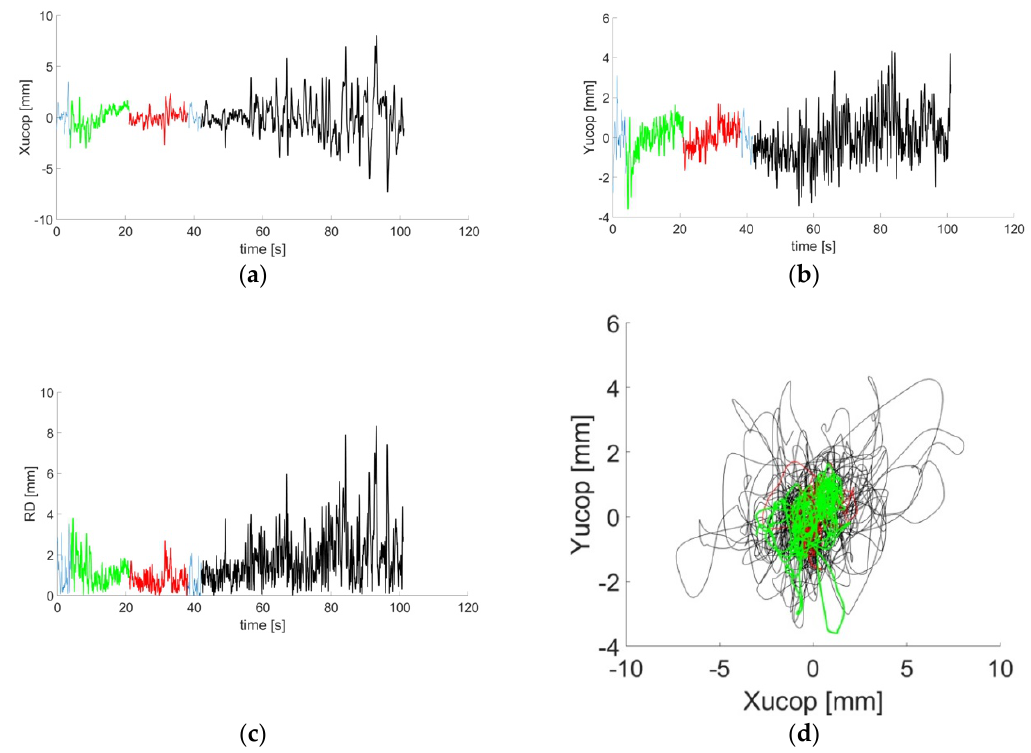
Figure 6. Time trends of the XUCOP ( a ), YUCOP ( b ) and RD ( c ), together with the corresponding stabilogram ( d ) for one of the participants.